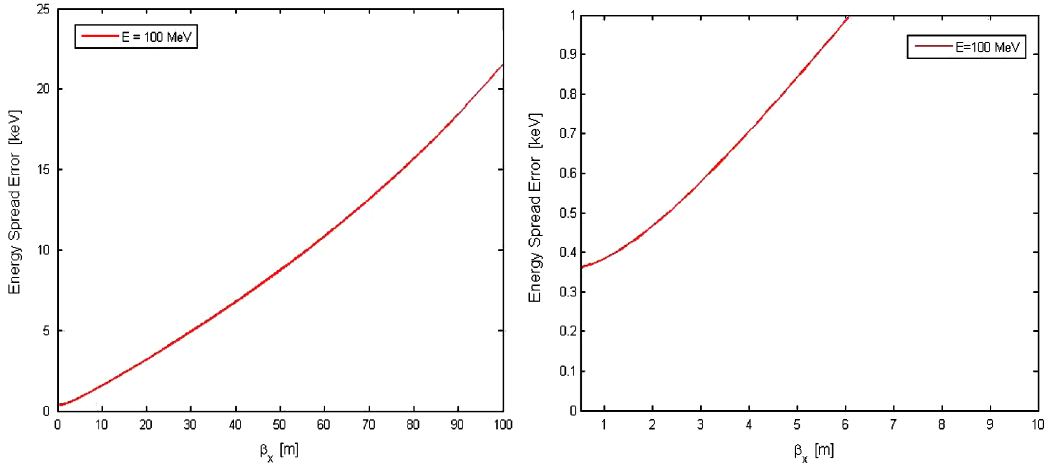
FIG. 12. Error on the energy spread measurement as function of the betatron function at the screen. A mean energy of 100 MeV is considered. Right plot, zoom on the low beta region.